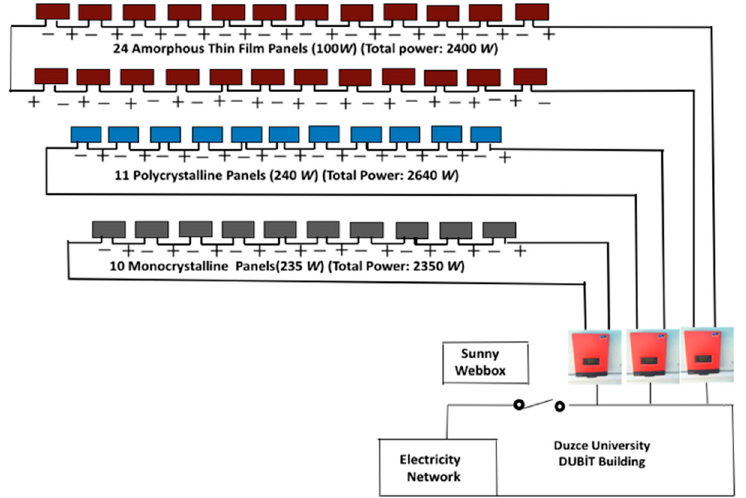
Figure 1. Three different PV solar panels of schemas in DUBIT in Duzce. As shown in Figure 1, the first type of panels used (P1) is an amorphous thin film silicon panel. A single P1 panel has the power of 100 W. In the proposed study, 24 P1 panels were utilized. The 24 P1 panels were structured in the form of a matrix with two rows and twelve columns (2 × 12). The total output power generated by the (P1) panels matrix equals 2400 W. The second type of panel (P2) is a polycrystalline silicon panel. A single P2 has a solar panel power of 240 W. Eleven P2 panels were utilized in the current study. The 11 (P2) panels were placed as a single row. That row produces a total power output of 2400 W. The third type of panel (P3) is a monocrystalline silicon panel. P3 produces a solar panel power of 235 W. Ten P3 panels were placed in a single row. Those have a total power output 2350 W. That system of panels (P1, P2, and P3) has been recording data every 5 min since 2013. Output power is recorded for each panel. Average temperature, radiation amount, and average atmospheric temperature were recorded for all